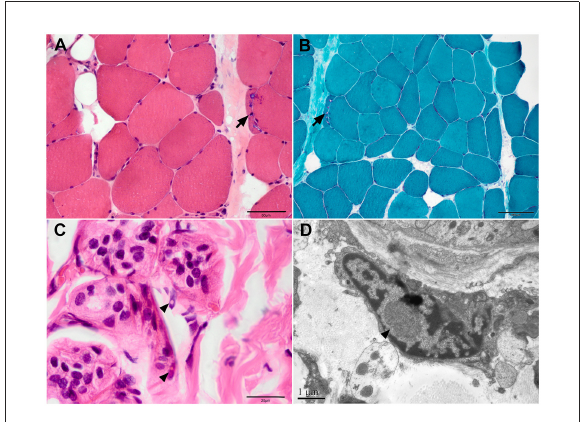
FIGURE2 Muscle and skin pathology of Patient 4. (A) Haematoxylin and eosin (HE), (B) modified Gomori trichrome staining on muscle samples showed myopathic changes with rimmed vacuoles (arrows). (C) HE staining and (D) electron microscopy of skin sections showed inclusions in the fibroblasts (arrowhead). Scale bars = 1 µ m (D) , 20 µ m (C) , 50 µ m (A) , 100 µ m (B)